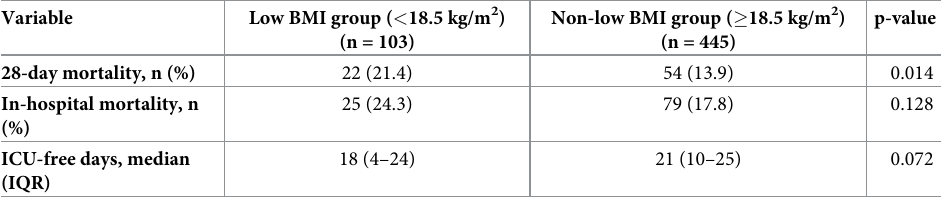
Table 4. Outcomes in patients in the low and non-low BMI groups.